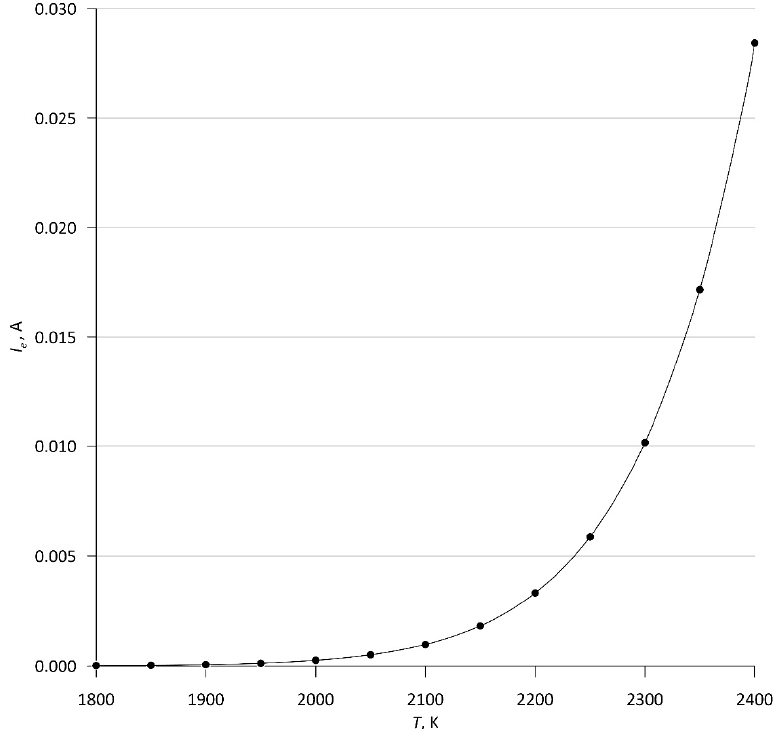
Figure A2. Model temperature dependence of the emission current I e for a tungsten cathode with a diameter of d = 0.00012 m and length l = 0.045 m. By combining the relationships shown in Figures A1 and A2, the characteristic of the intensity I e of the emission current as a function of the intensity I c of the cathode heating current, which is illustrated in Figure A3, was determined.